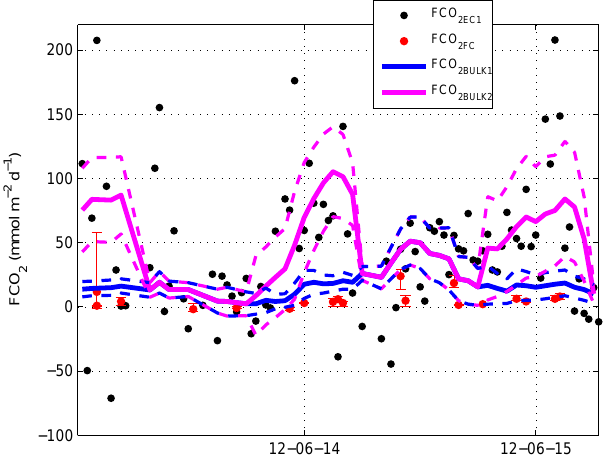
Figure 8. Time series from the field campaign in 2012, of FCO 2EC1 , (black dots), FCO 2FC , (red dots), FCO 2BULK1 , CO 2 flux calculated using the bulk flux estimation of Cole and Caraco (1998) (solid blue line) and FCO 2BULK2 , CO 2 flux estimations using the bulk flux equation with k dependent on both wind speed and water- side convection, i.e. Rutgersson and Smedman (2010) parameteri- zation (magenta line). The upper and lower dashed blue and ma- genta lines represent the bulk flux estimations using p CO 2wSAMI + 200ppm and p CO 2wSAMI − 200ppm,